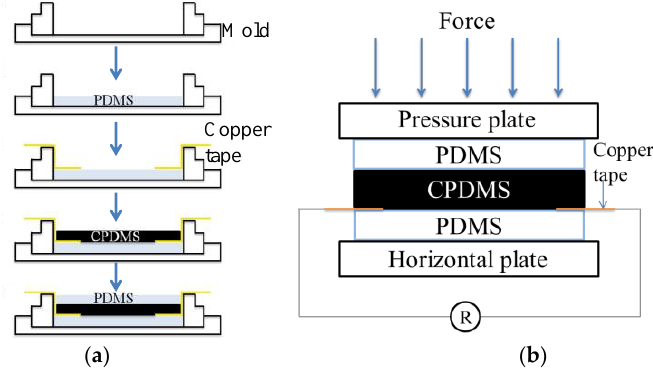
Figure 5. Piezoresistance measurement. ( a ) Preparation and ( b ) CPDMS resistance measurement under different pressure.